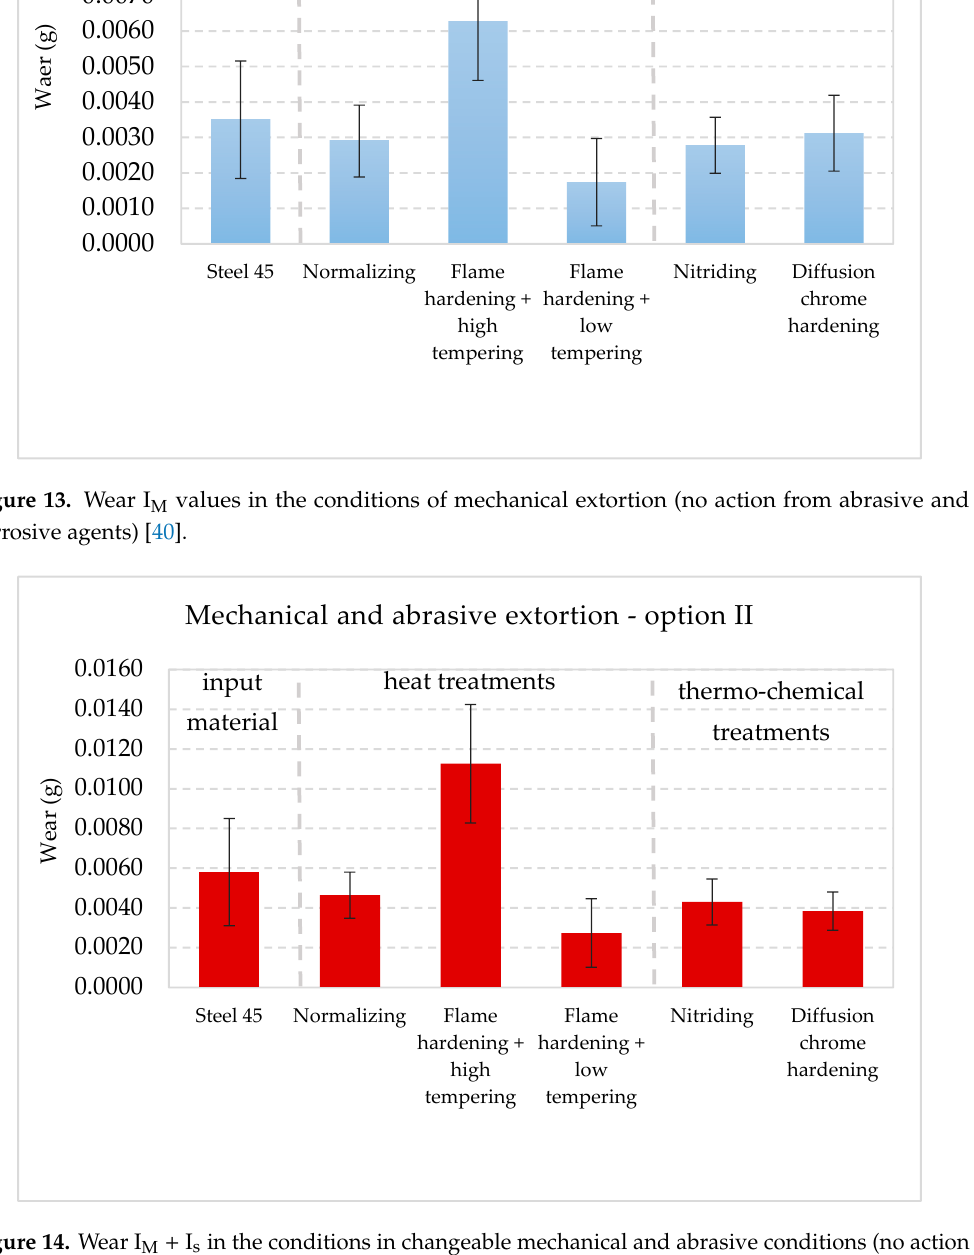
Figure 14. Wear I M + I s in the conditions in changeable mechanical and abrasive conditions (no action from corrosive agents) with 90% confidence semi-intervals [40].